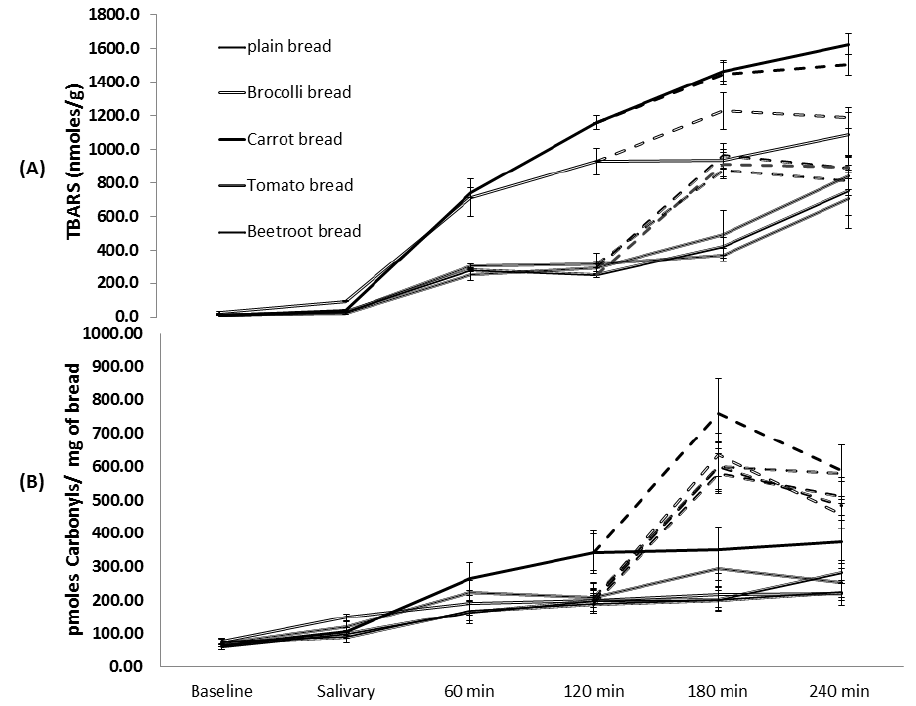
Figure 5. Temporal changes in TBARS ( A ) and protein carbonyls ( B ) production during gastrointestinal digestion of the breads. Solid and broken lines represent the salivary/gastric, and intestinal phases of digestion respectively. Values are means ± SE ( n = 6).